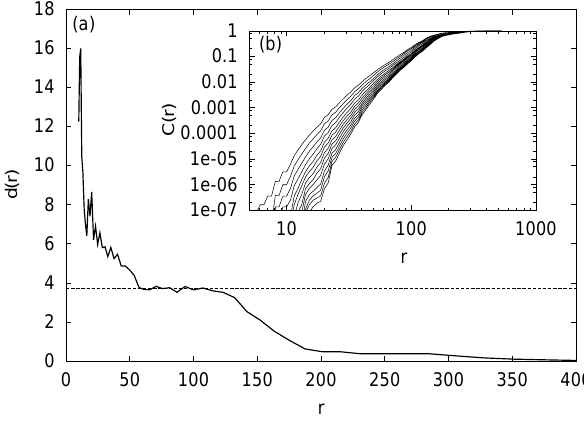
Fig. 4. (a) Local slopes of the logarithm of the correlation sum for the geomagnetic horizontal intensity H for m = 12 , τ = 10 and ω = 100 . The correlation dimension D = 3 . 70 ± 0 . 04 . (b) The correlation sum C(r) of H for m = 8 , 9 ,..., 20 , τ = 10 and ω = 100